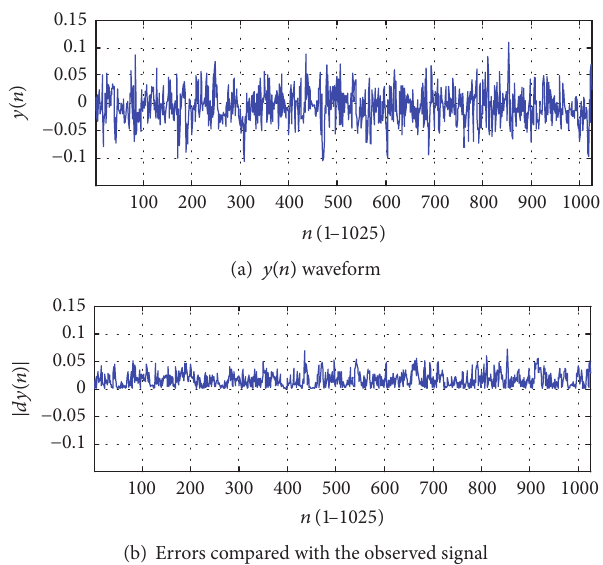
Figure 9: The output signals 𝑦(𝑛) calculated by 𝑥𝑥(𝑛) and their